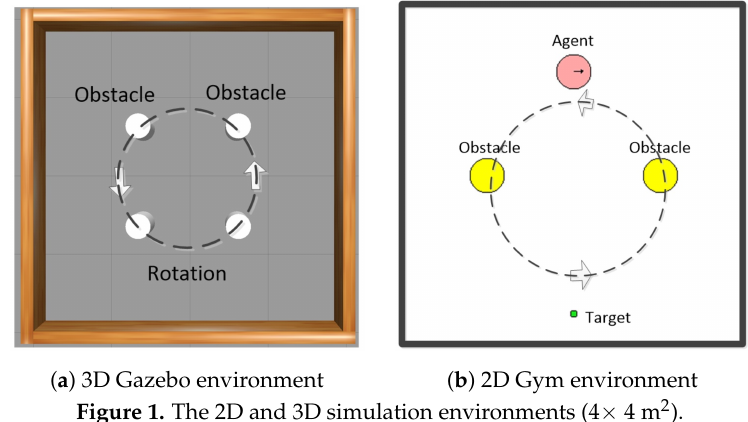
Figure 1. The 2D and 3D simulation environments (4 × 4 m 2